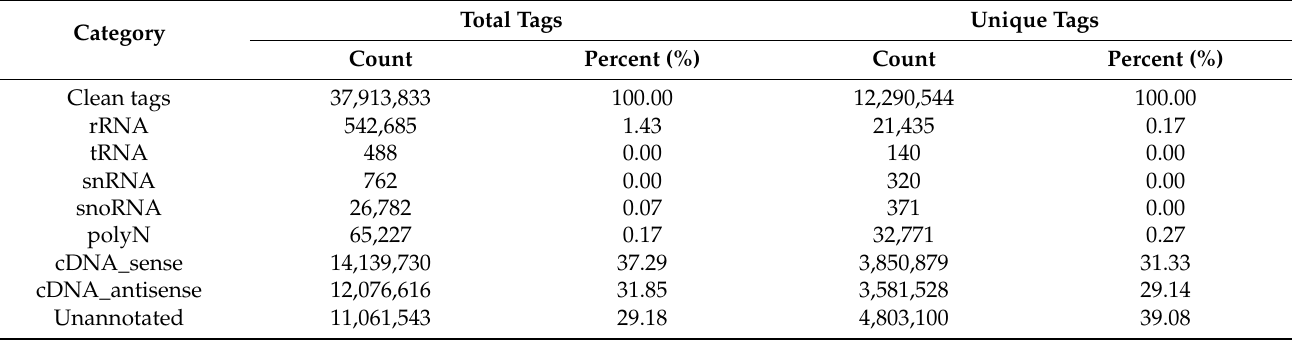
Table 2. Annotation and classification of degradome